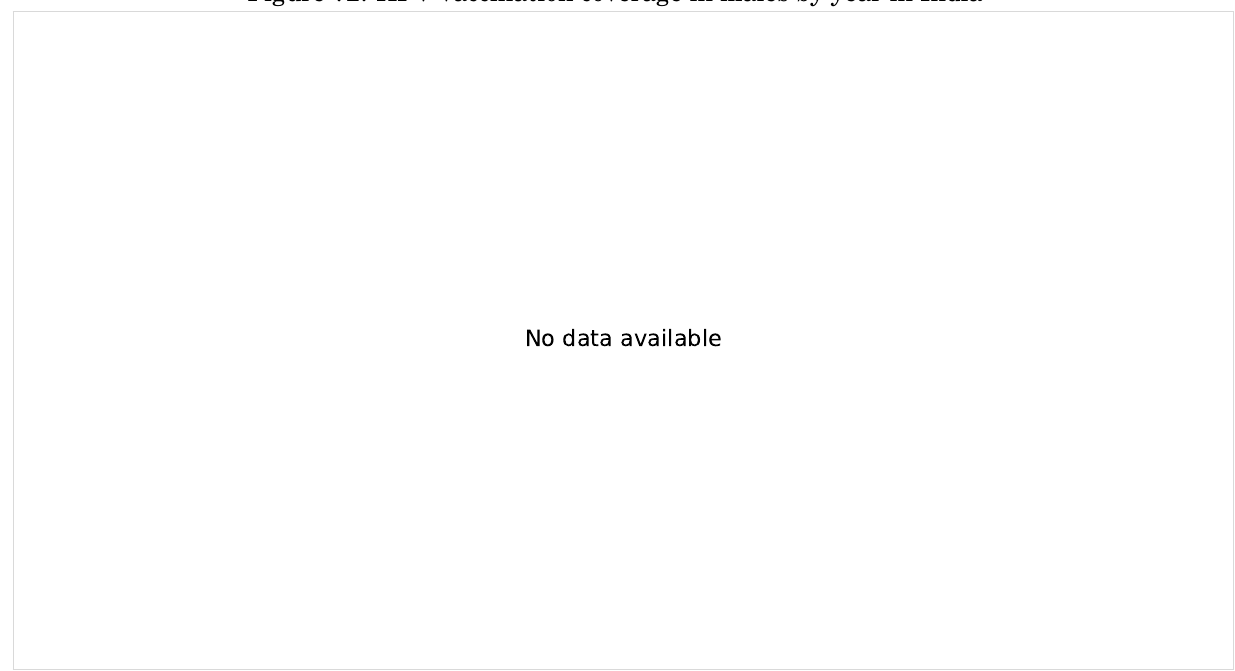
Figure 72: HPV vaccination coverage in males by year in India